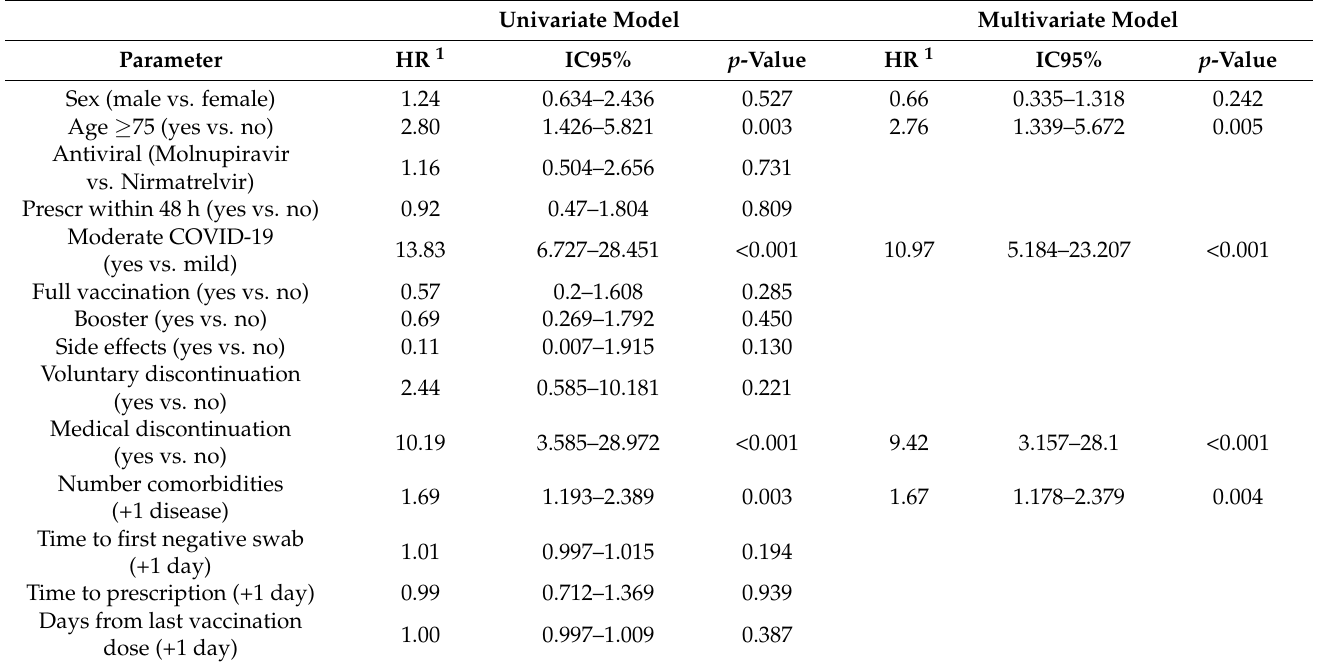
Table 5. Factors associated with 30-day progression-free survival toward composite